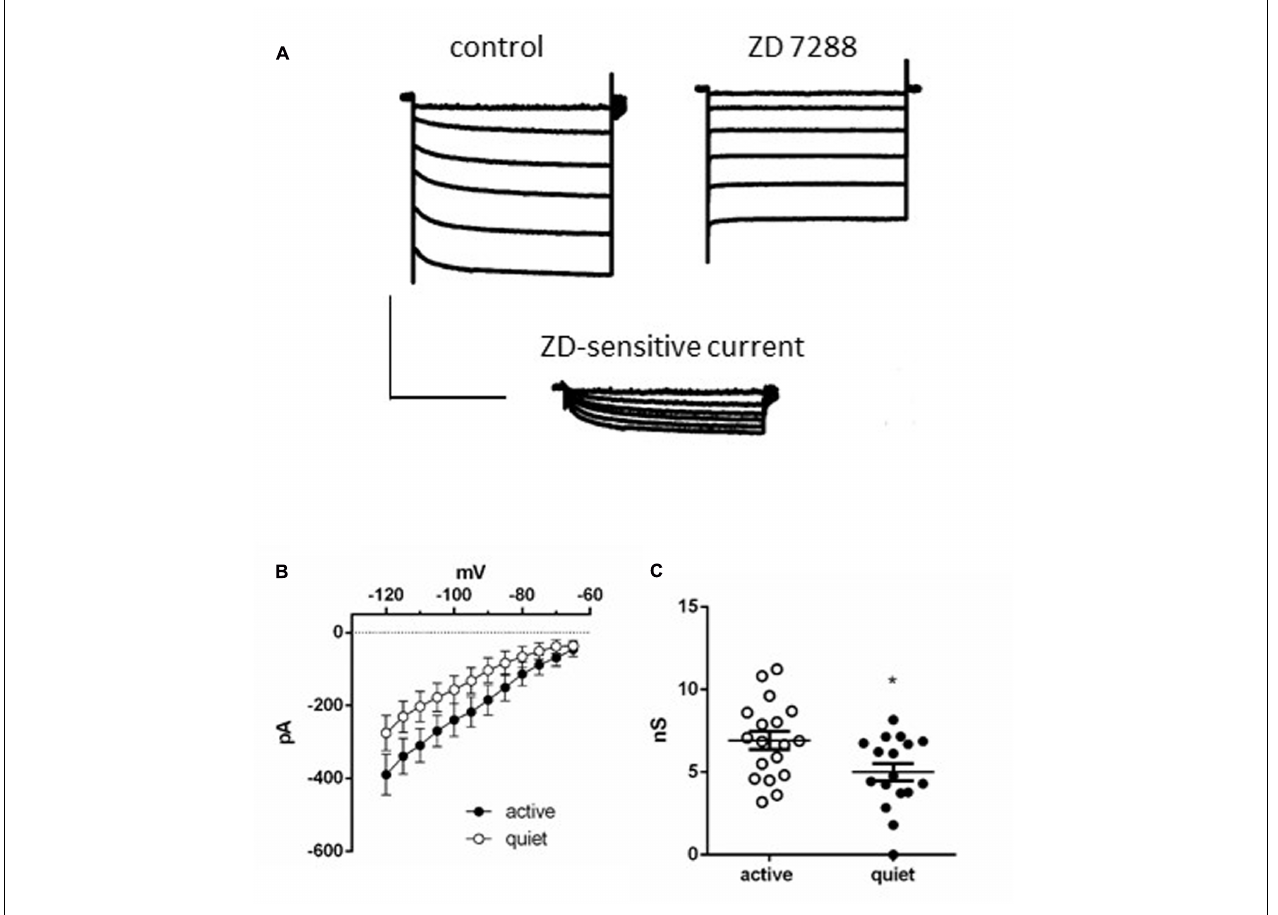
FIGURE 2 | I h in DCN fusiform neurons. (A) Example of currents activated by a membrane hyperpolarization before (left) and after (middle) application of ZD7288 (20 µ M). Bottom: subtraction of the control currents by the same currents after application of ZD 7288. (B) Current-voltage relationships of the ZD 7288 sensitive current ( I h ) in quiet and active fusiform neurons. (C) Summary of the slope conductances of I h in quiet and active fusiform neurons. ∗ p < 0.05.